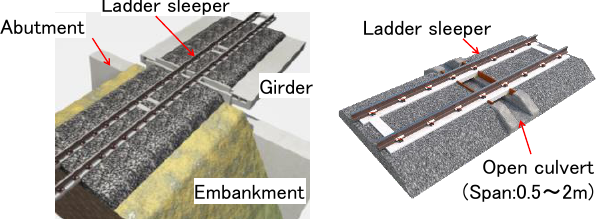
Figure 20. Recommendation of the way of ladder sleeper at the structural boundary.